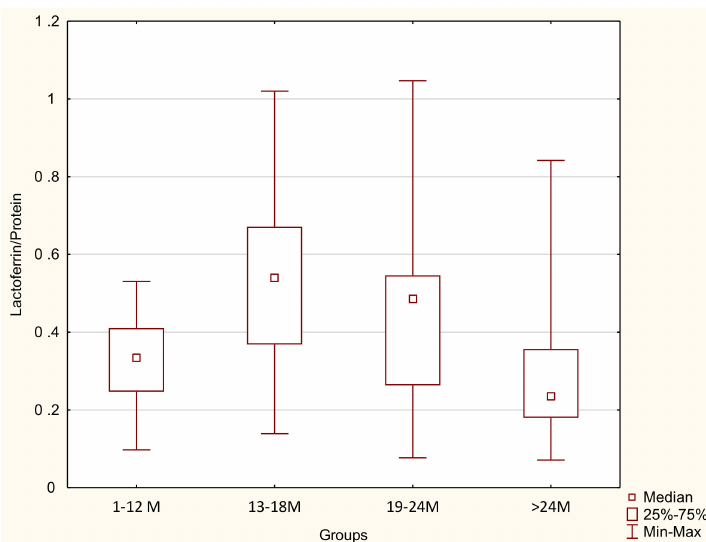
Figure 2. The coe ffi cient of lactoferrin to the protein concentration in the four groups analyzed: Group1 up to 12 months ( n = 24), group 2 from 13 to 18 months ( n = 33), group 3 from 19 to 24 months ( n = 37), and group 2 above 24 months ( n = 26).